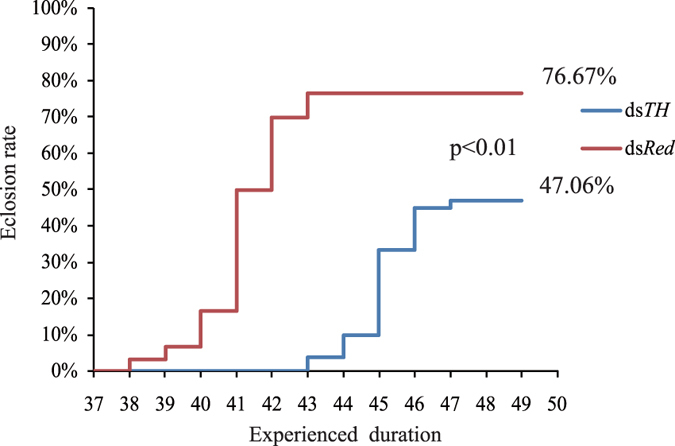
Comparison of eclosion rates and times between the dsTH and dsRed groups (log rank test, p < 0.01).